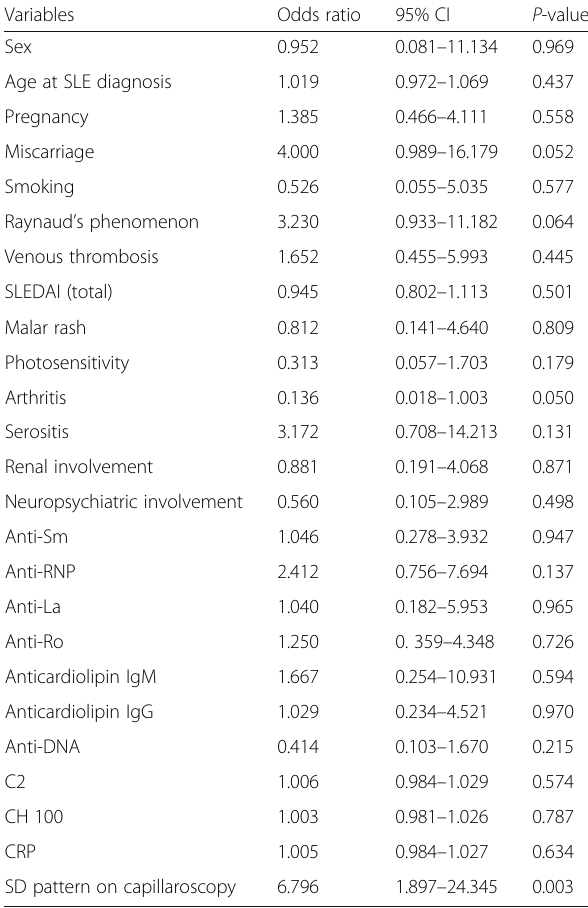
Table 6 Variables associated with PAH among SLE patients in the univariate logistic regression analysis